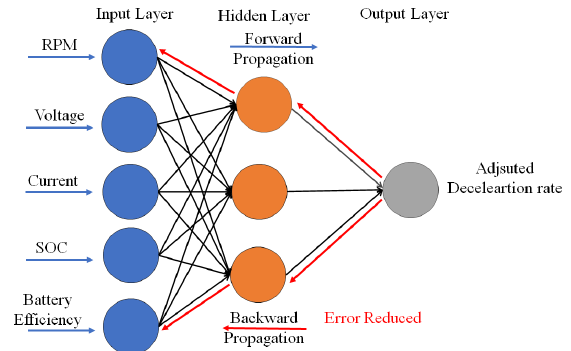
Figure 10. Layout of artificial neural network model of forward and backward